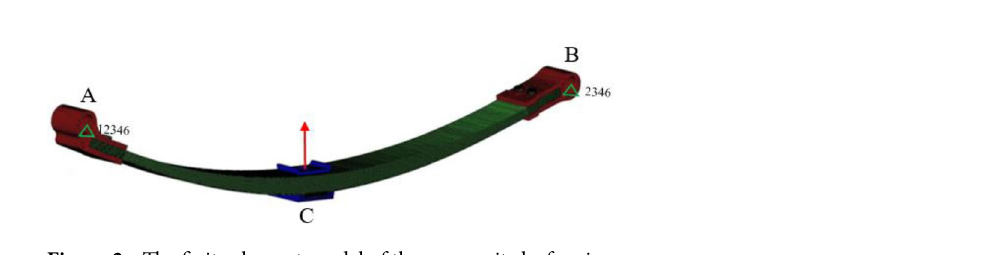
Figure 2. The finite element model of the composite leaf